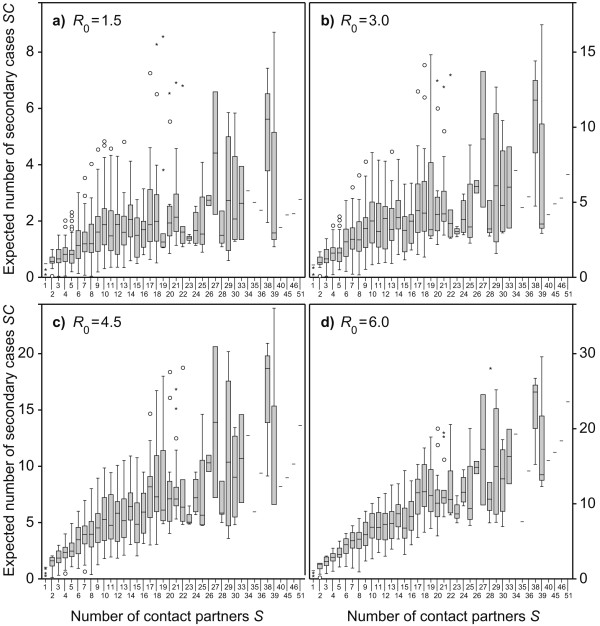
Expected number of secondary cases versus number of contacts. The boxplots show the distribution of the expected number of secondary cases that are induced by one infector that is introduced into a fully susceptible population. The values are grouped by the number of contact partners of the infectors. The boxes represent the interquartile range (IQR) with the median values marked as horizontal line. The whiskers are defined as max. ± 1.5·IQR. Circles are outliers and asterisks are extreme outliers. The subfigures represent the following basic reproduction numbers: a) R0 = 1.5; b) R0 = 3.0; c) R0 = 4.5; d) R0 = 6.0. Subfigures a-c are cropped such that one outlier lies outside the displayed range. The corresponding person day had 28 reported contacts and amounts SC = 14.15 for subfigure a, SC = 24.00 for b, and SC = 27.76 for c. The rationale for this outlier is presumably a reporting bias from the participant; i.e., the participant stated that she or he had close contact lasting for hours with a large number of persons at a festivity. Interacting closely with a large number of persons at a festivity over long time is almost impossible when the rigid contact definition in the diary is used.